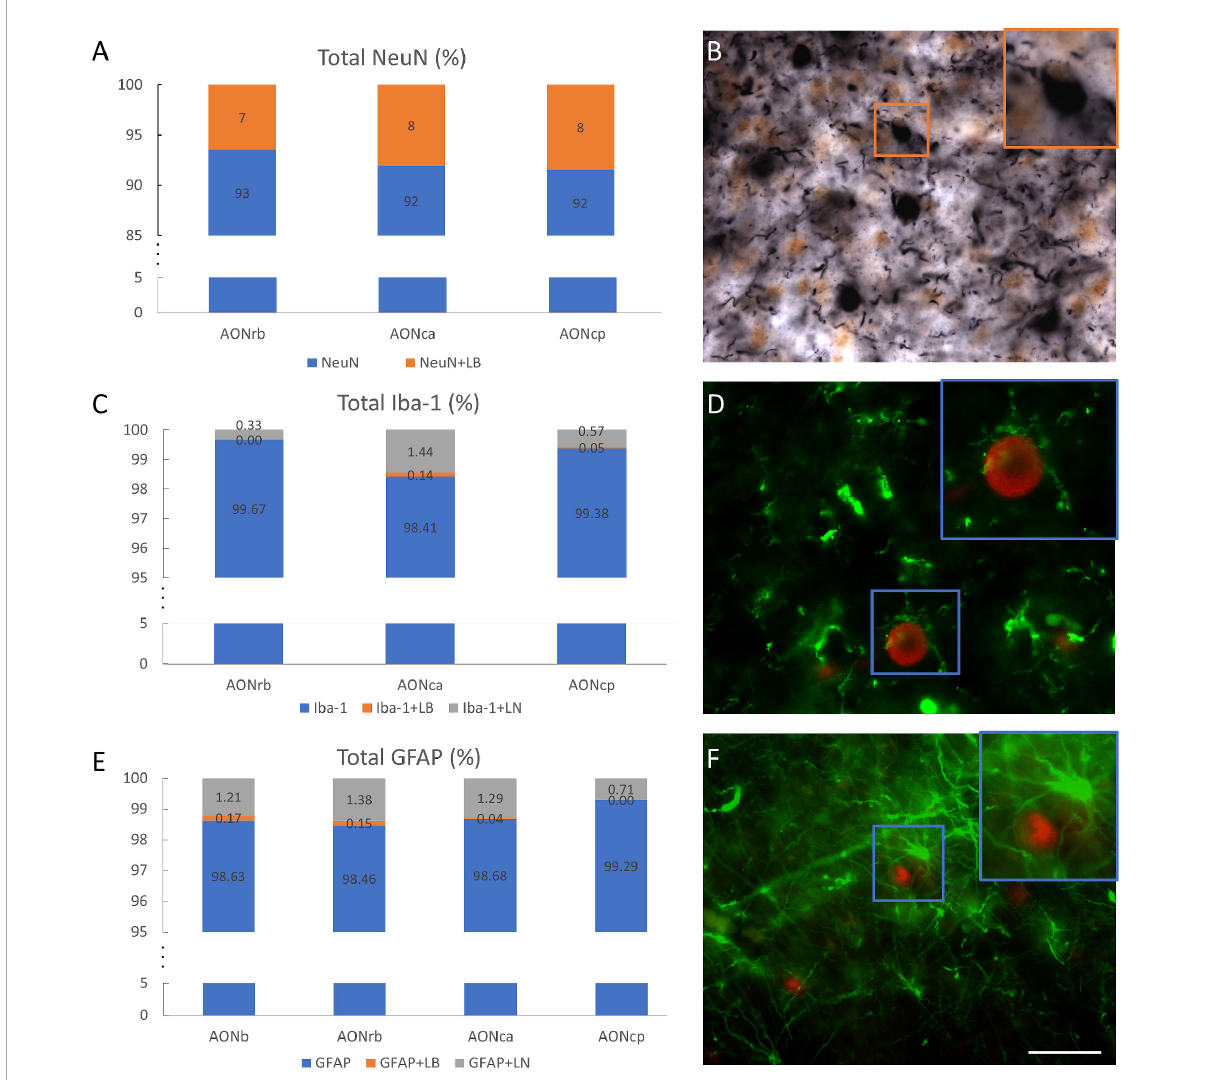
FIGURE5 Overlap of cell populations and α -synuclein. Percentage of total NeuN–NeuN without overlapping (blue) and NeuN superimposed with LBs (orange) in different portions of the AON (A) . Double immunohistochemistry against NeuN (brown) and α -syn (black). The square indicates the overlap between NeuN and LBs (B) . Percentage of total Iba-1-Iba-1 without overlapping (blue), Iba-1 superimposed with LBs (orange) or LNs (gray) in different portions of the AON (C) . Double immunofluorescence against Iba-1 (green) and α -syn (red) (D) . The square indicates the hug between Iba-1 and LB. Percentage of total GFAP-GFAP without overlapping (blue), GFAP superimposed with LBs (orange) or LNs (gray) in different portions of the AON (E) . Double immunofluorescence against GFAP (green) and α -syn (red) (F) . Squares indicate the hug between GFAP and LB. Scale bar: 25 µ m.